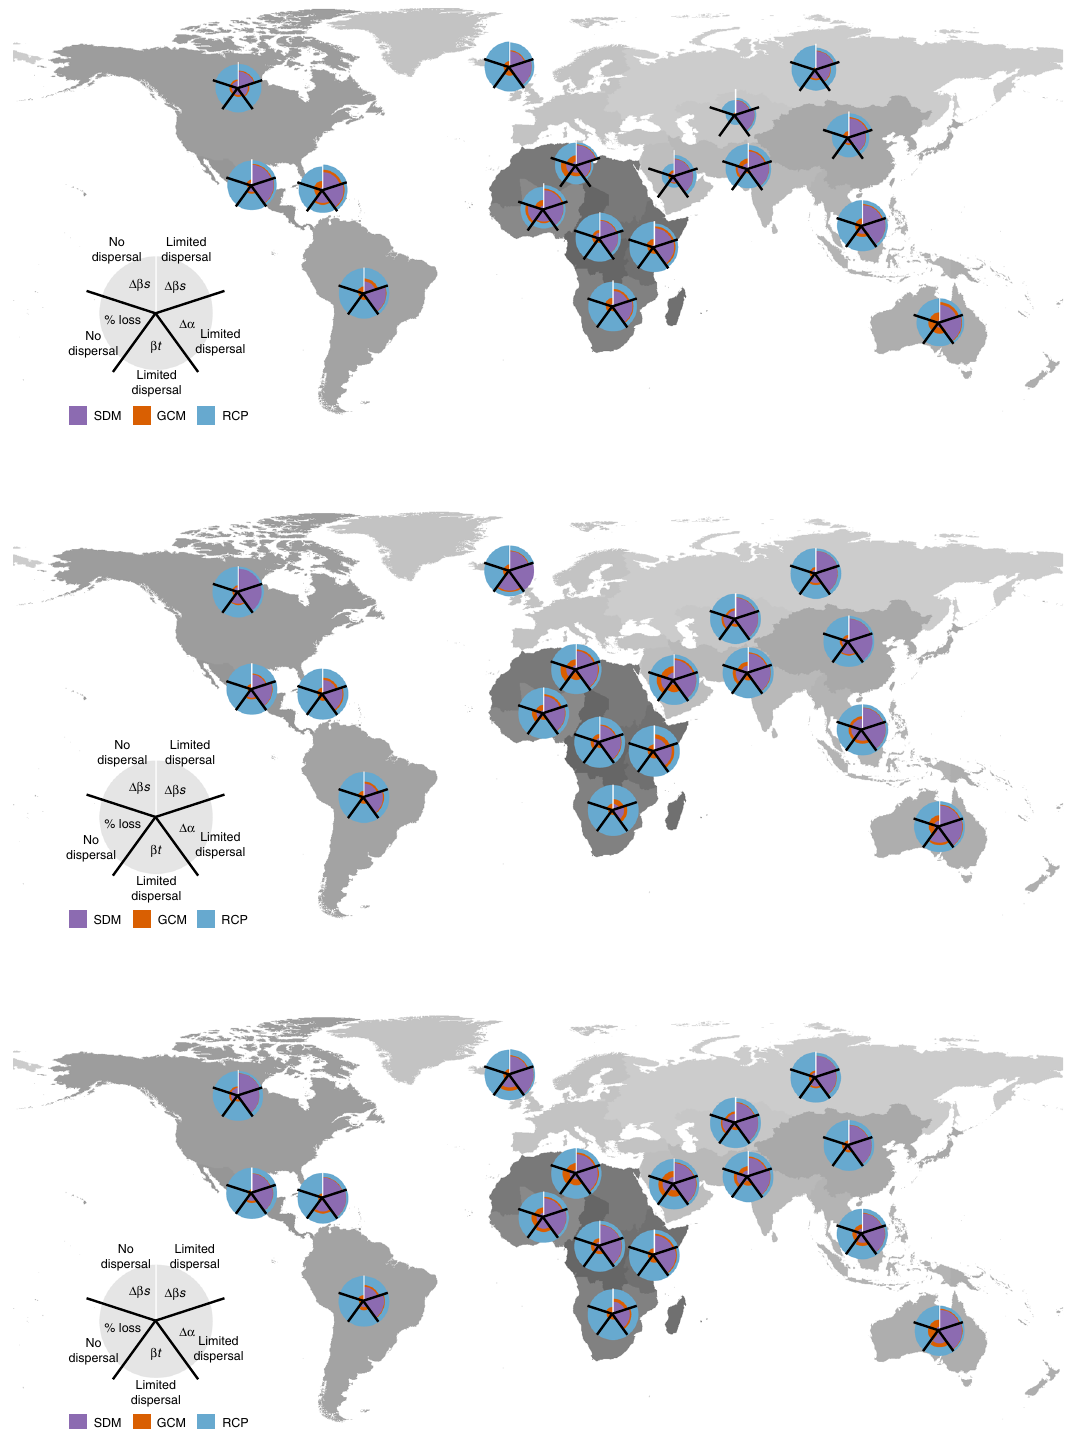
Fig. 4 Spatial variation of the relative in fl uence of the different sources of variation. The maps represent the relative in fl uence (i.e. % of explained variance) of the choice of species distribution models (SDMs), global circulation models (GCMs) and representative concentration pathways (RCPs) on the change in α -diversity per-pixel ( Δα ), temporal species turnover ( β t), percentage of species loss per pixel and change in β -diversity per IPBES sub-region ( Δβ s). Results are for the time period 2061 – 2080 (see Supplementary Fig. 9 for the period 2041 – 2060). Top row corresponds to amphibians, middle row to birds, and bottom-row to